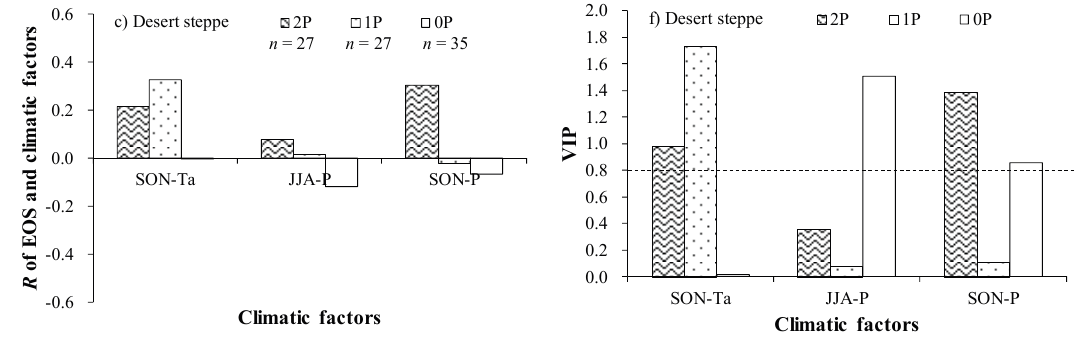
Figure 7. Correlation ( a–c ) between EOS and climatic factors for the three grassland types with three frozen ground types and VIP ( d–f ) for considered variables. * indicates the significance level of 0.05 and ** indicates the significance level of 0.01. The n is the number of phenological records for EOS. The 0P, 1P, and 2P represent seasonal frozen ground, sporadic permafrost, and permafrost,